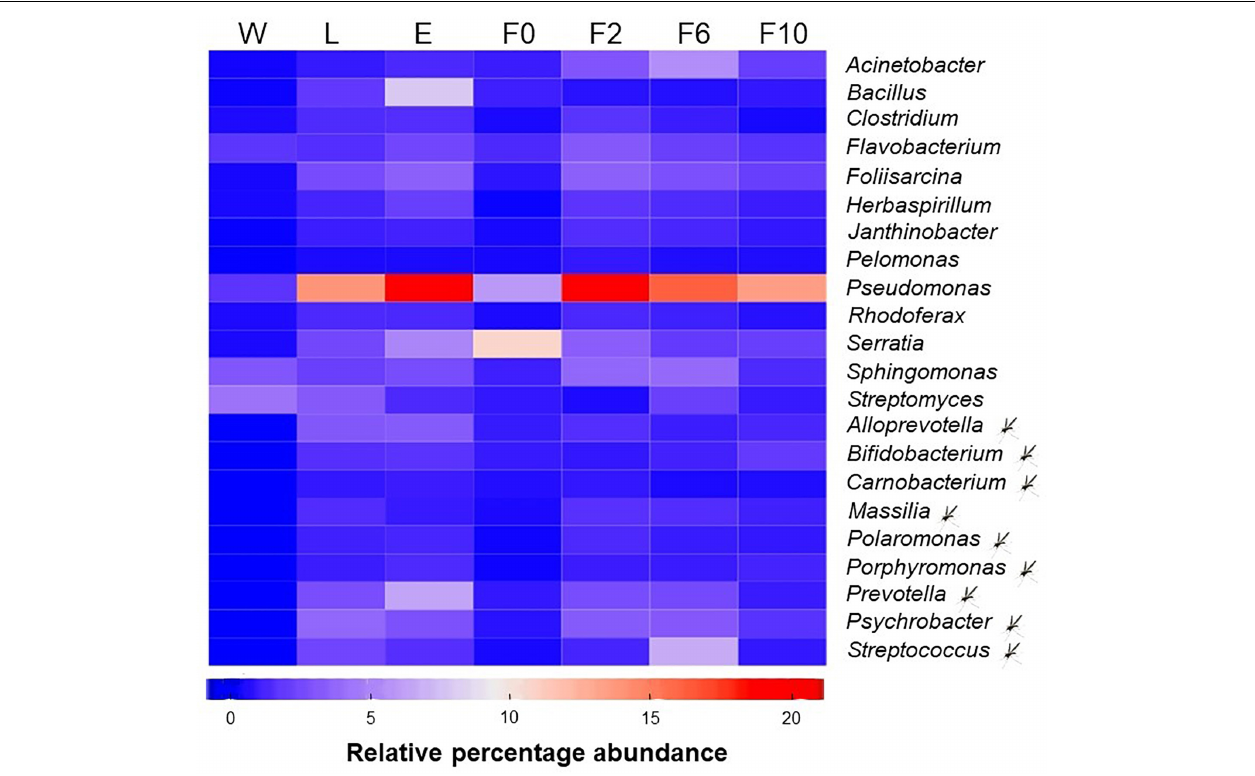
FIGURE 5 | Core microbiota of An. atroparvus . Heatmap showing the relative abundance of bacterial genera identified in two out of three pools per sample type with more than 10 reads that are common to all mosquito samples. Genera marked with a mosquito represent core bacteria present in larvae and adult females but not in natural breeding water. Genera without the mark represent core bacteria detected in all sample types. Sample types: W, breeding water; L, larvae; E, newly emerged females; F0, wild-caught females; F2, F6, and F10, laboratory-reared females from the second, sixth, and 10th generations,